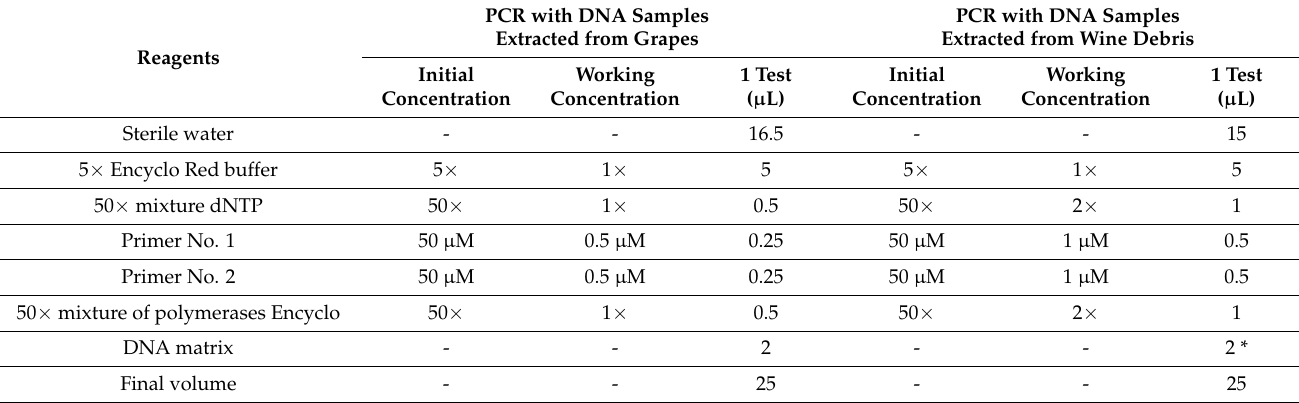
Table 3. Protocols for preparing reaction mixtures for PCR with DNA samples extracted from grapes and wine